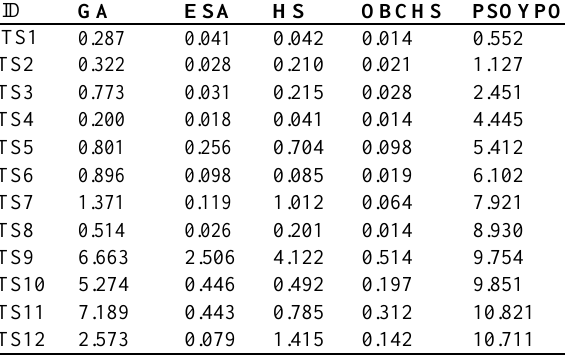
Table 7. Comparison of computational performance for normal scale problems